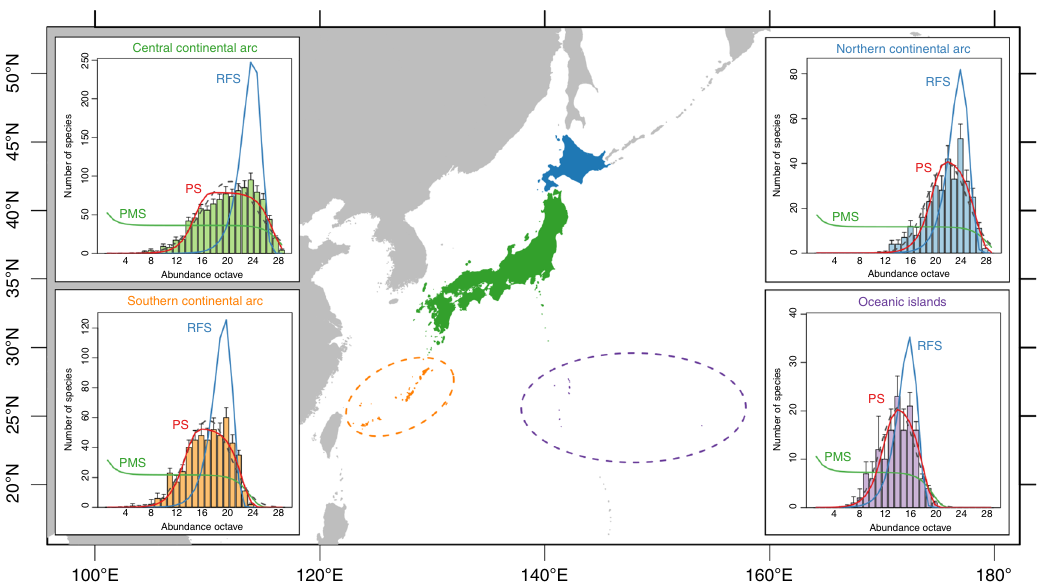
Fig. 4 Metacommunity species abundance distribution in the four ecoregions of the East Asian islands. Ecoregions are discerned by colour (central continental arc: green, northern continental arc: blue, southern continental arc: orange, oceanic islands: purple). Histograms in the inner panels represent the estimated metacommunity species abundance distributions (SADs). Error bars indicate standard errors. The coloured lines represent metacommunity SADs predicted by the three variants of the uni fi ed neutral theory of biodiversity and biogeography (UNTB) (PMS – point mutation speciation model; RFS – random fi ssion speciation model, PS – protracted speciation model) fi tted to the metacommunity SADs. Dashed lines represent fi tted Poisson-lognormal models as simple statistical baselines. The j th abundance octave is de fi ned as the range of abundance n satisfying 2 j − 1 ≤ n < 2 j .